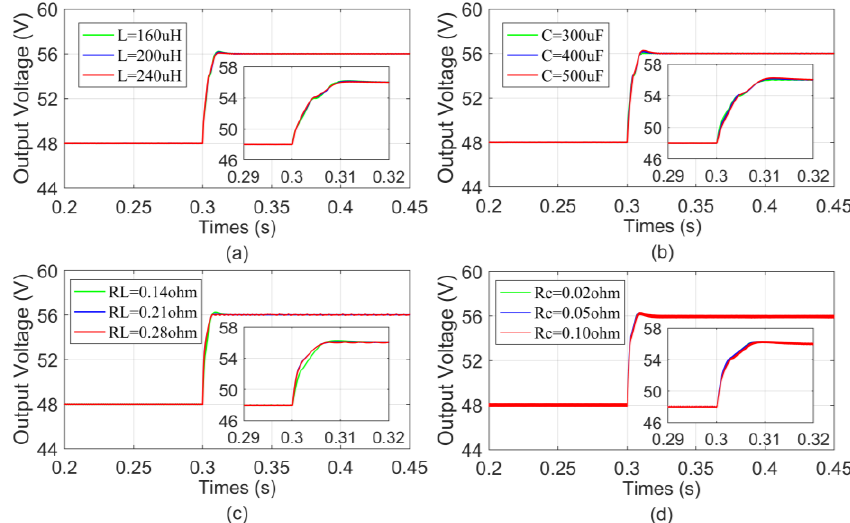
Figure 4. Dynamic response of converter under parameter uncertainties: ( a ) the variation of inductance; ( b ) the variation of capacitance; ( c ) the variation of parasitic resistance of the inductor; ( d ) the variation of parasitic resistance of the capacitor.